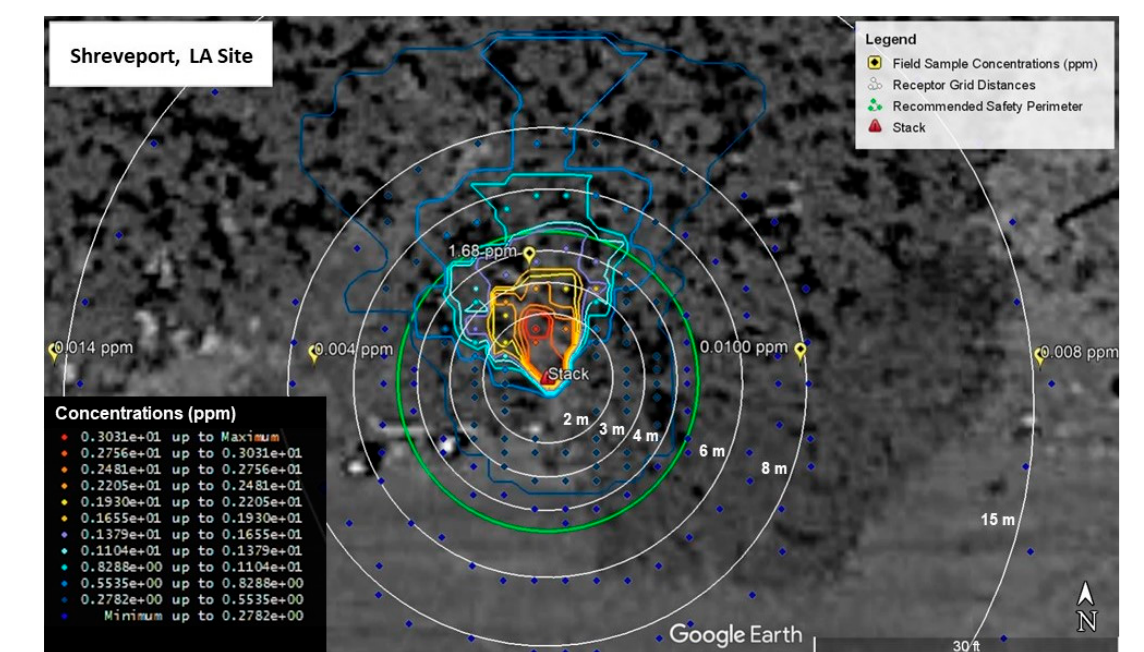
Figure 5. Modelled Styrene Emission Calibrated to Field Sample Concentrations (Shreveport, LA, USA).